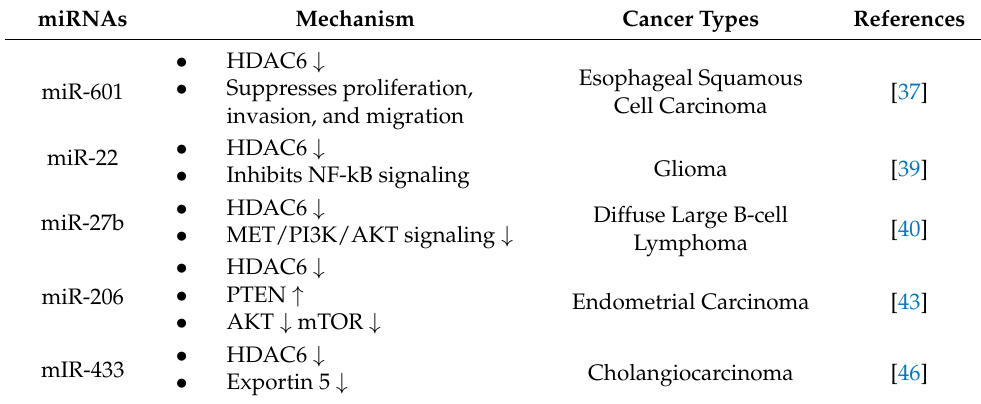
Table 2. Role of HDAC6-targeting microRNAs in cancer cell proliferation. miRNAs